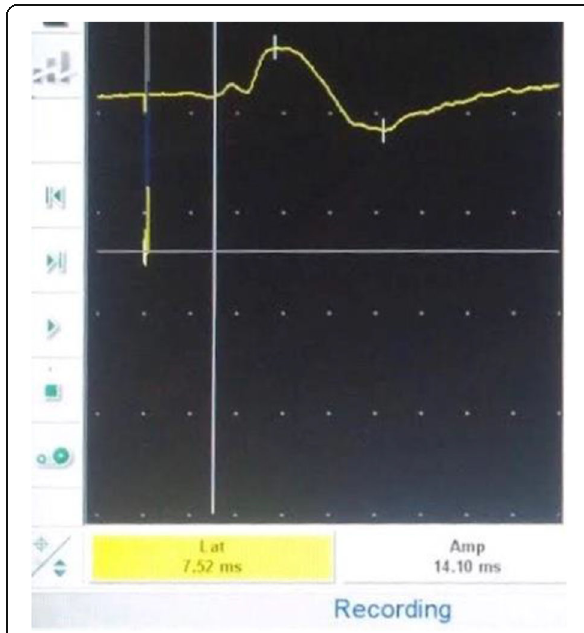
Fig. 2 Phrenic NCS showing delayed DML (7.52) in one of our patients, phrenic n. DML cutoff > 7.2 ms and amplitude